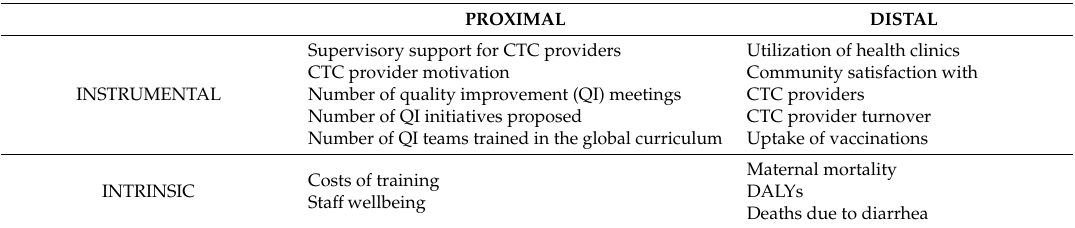
Table 1. Outcomes impacted by REACHOUT, categorized as instrumental vs. intrinsic and proximal vs.